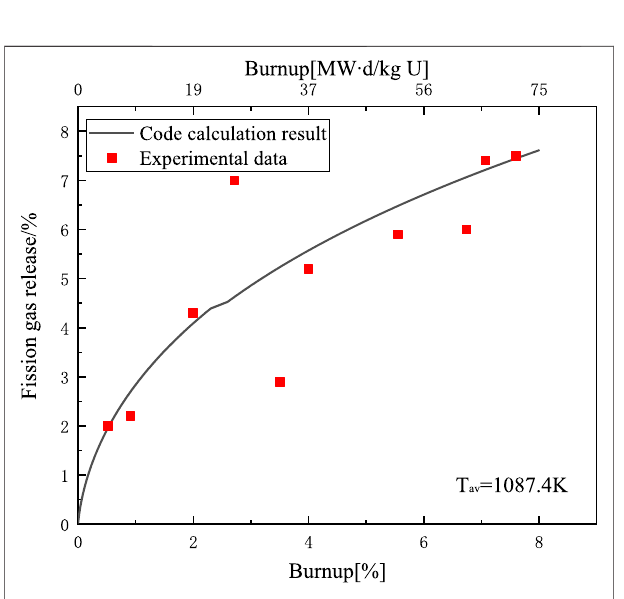
FIGURE 10 | Fractional fi ssion gas release versus burnup.